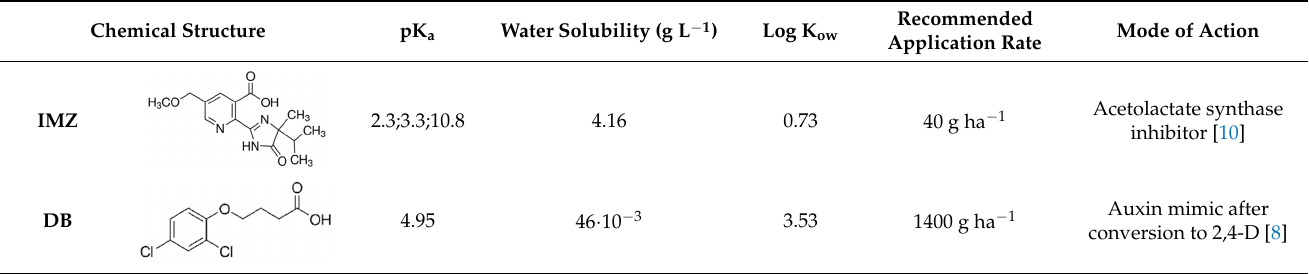
Table 1. Selected physicochemical properties of imazamox (IMZ) and 2,4-DB (DB), recommended application rates and mode of action. Chemical